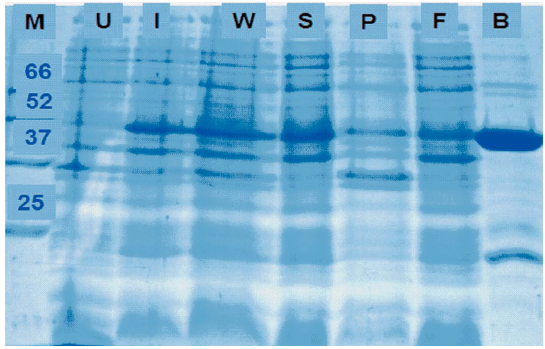
Figure 2 SDS gel image of M1dr Zn-NTA purification. M = protein marker (numbers shown in kDa), (U)I = (Un)introduced, W = cell lysate, S = supernatant after spin, P = pellet after spin, F = flow through after Zn binding, B = bound M1